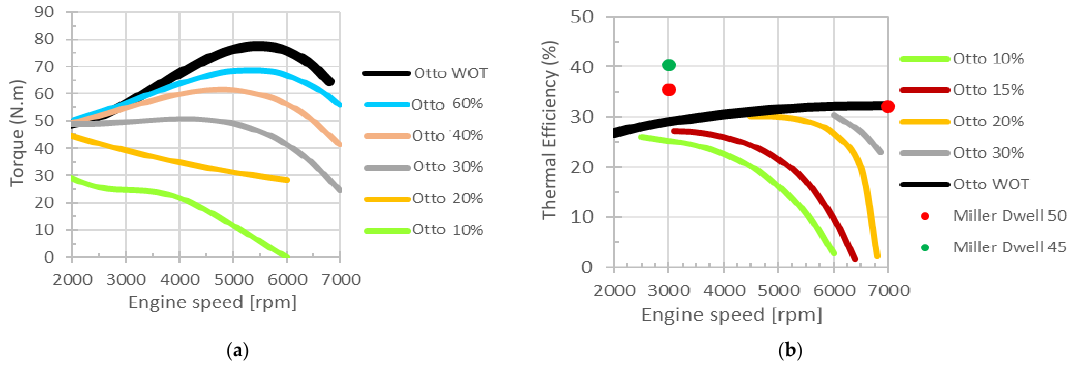
Figure 5. ( a ) Measured torque as a function of engine speed, for various positions of the throttle position sensor (TPS) for the stock K75 engine and ( b ) comparison between experimental values of the stock (lines) and over-expanded (dots) engine efficiencies.